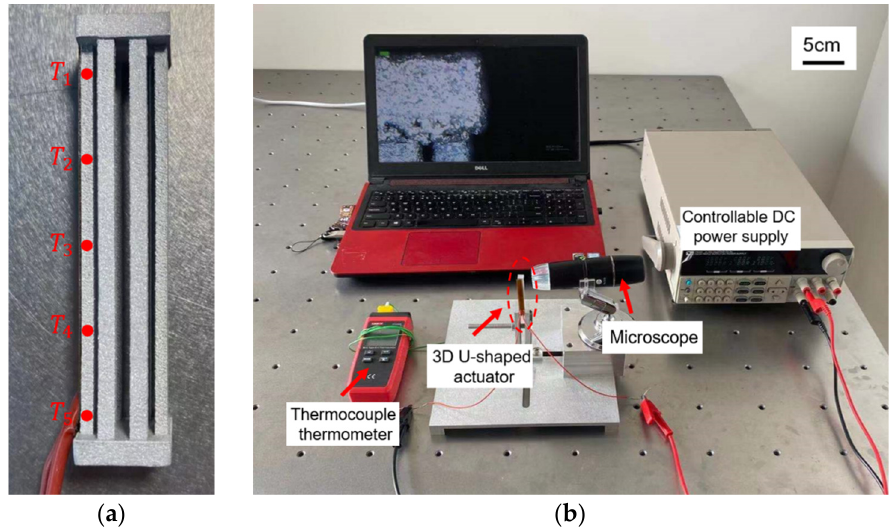
Figure 8. Experimental setup. ( a ) the fabricated 3D U-shaped electrothermal actuator with the polyimide film; ( b ) measuring devices.